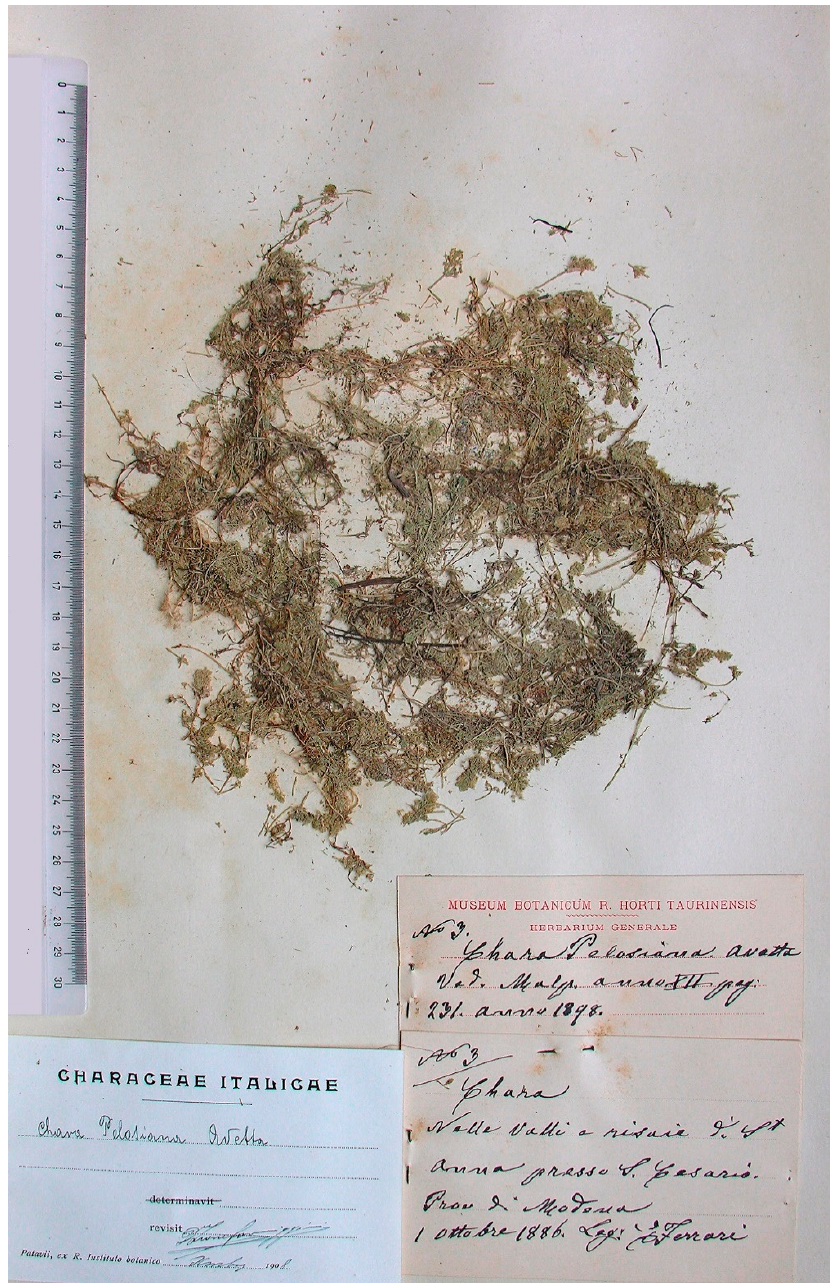
Figure 3. TO specimen of Chara pelosiana (No. 3) from the second duplicate of Ferrari’s original collection. Ferrari’s two handwritten labels (on the right) and Formiggini’s revision label (on the